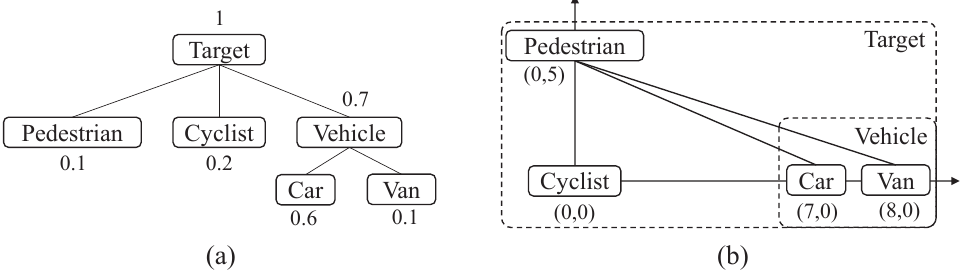
Figure 2. Diagram of example. ( a ) A simple category tree example with a root node “target” and two levels of classification labels. ( b ) The confusion costs between the individual labels “pedestrian”, “cyclist”, “car”, and “van”, embedded into a plane of Euclidean space. Table 1. The label metric generates 15 pairs of distance between HMC labels. (Abbreviations: Ped—Pedestrian, Cyc—Cyclist, Veh—Vehicle, and